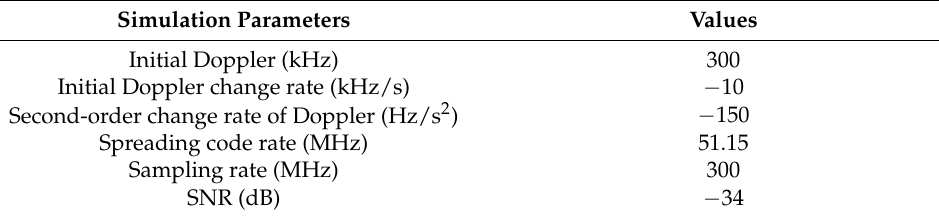
Table 1. China Space Station analog signal parameters.